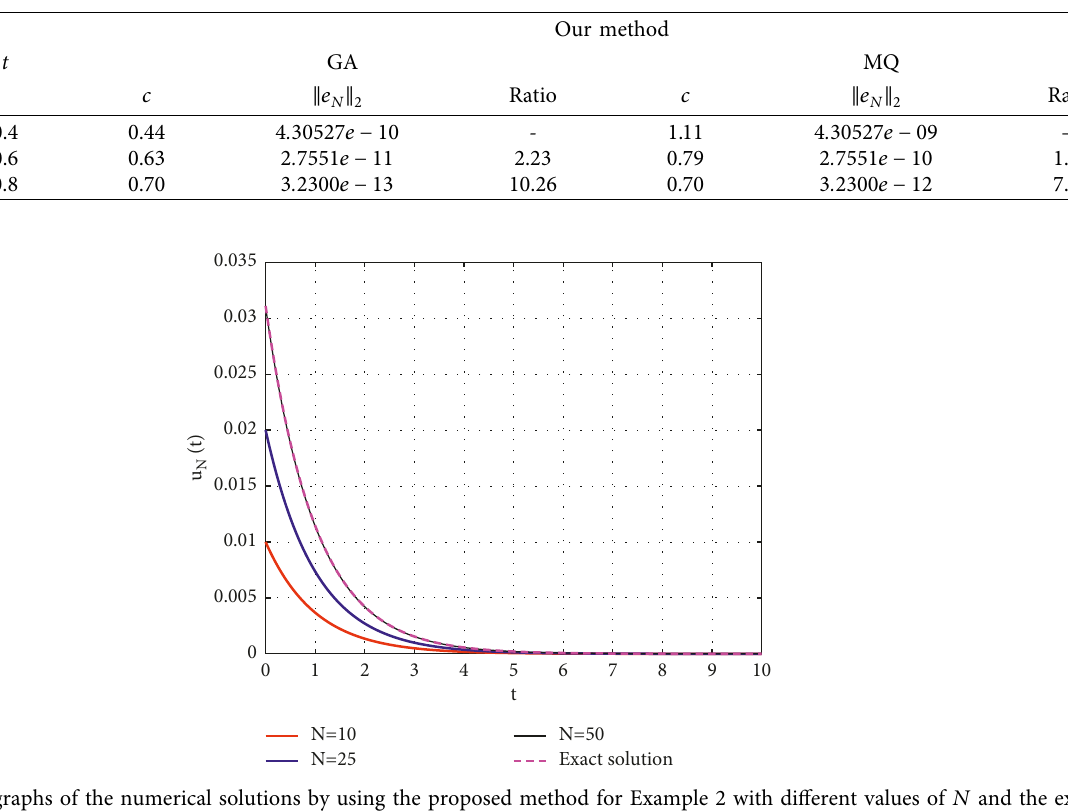
Figure 5: The obtained errors by using the proposed method for Example 1 with different values of N . Table 2: The absolute errors of the numerical solutions by using the proposed method for Example 1.